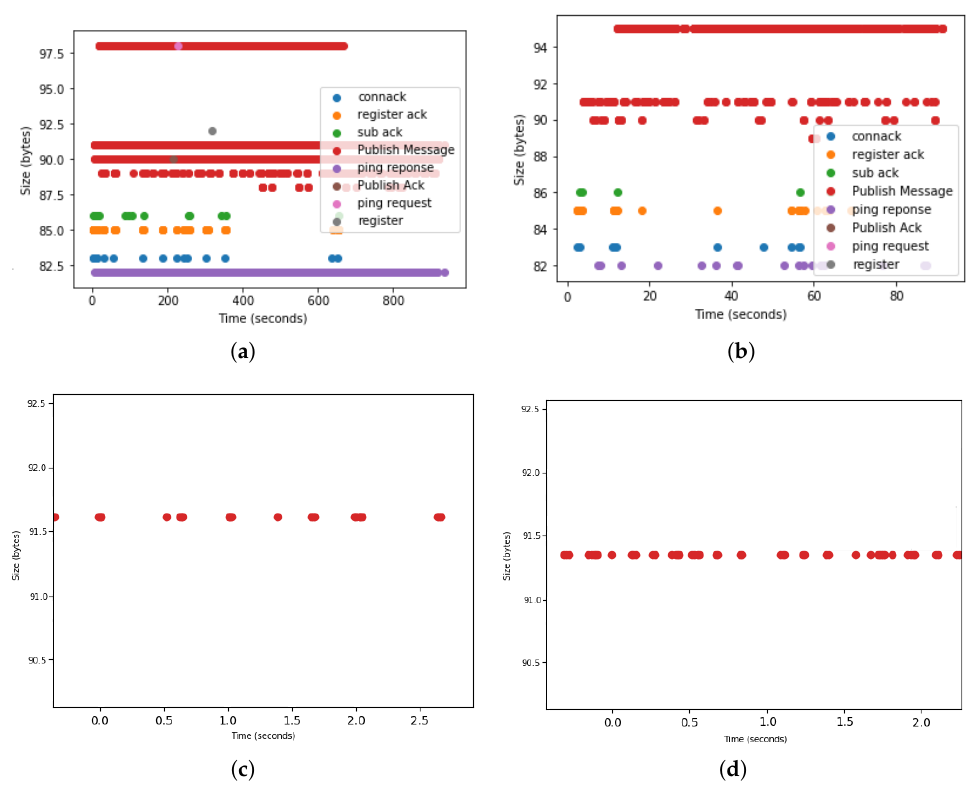
Figure 20. Congestion attack evaluation diagrams. ( a ) MQTT-SN traffic in the legitimate scenario. ( b ) MQTT-SN traffic in the attacked system. ( c ) MQTT-SN most-common topic frequency without attacks. ( d ) MQTT-SN most-common topic frequency on an attacked system.